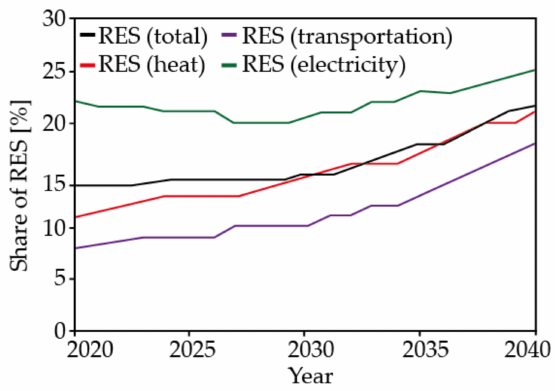
Figure 10. Future trends of RES share in total energy mix